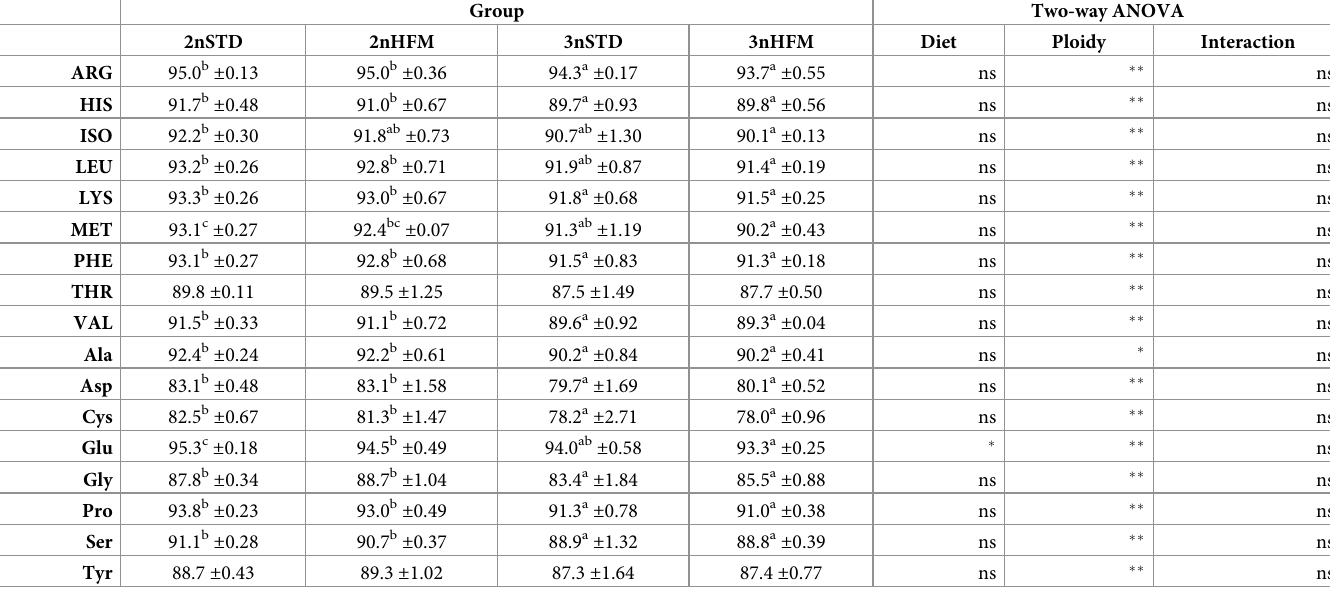
Table 6. Apparent digestibility coefficients of individual AAs in each diet and ploidy